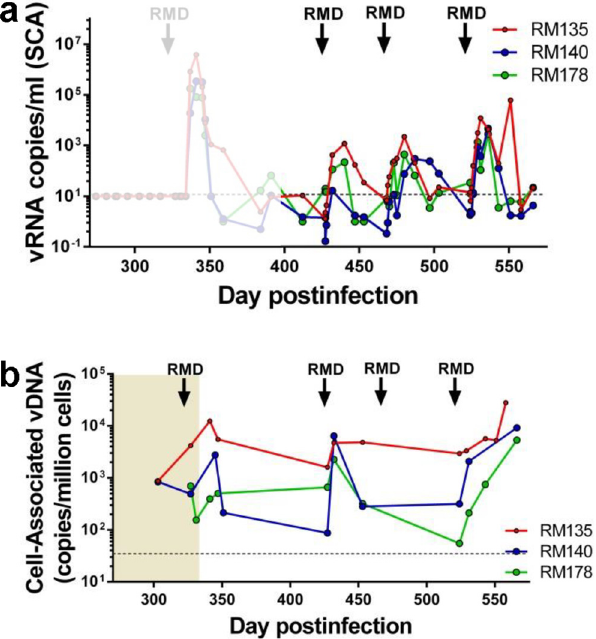
Fig 5. SIVsmmFTq reactivation after RMD administration in post-treatment controller RMs, as monitored by measuring the levels of PVLs and total CD4 + memory T cell-associated vDNA. (a) PVLs were measured using SCA, with a LOD of 1 copy/ml. Due to limitations in sample availability, the actual sensitivity of the SCA was of 5 – 10 copies (illustrated as a dashed line at 10 copies/ml). For comparison, the dynamics of PVLs at the cessation of ART are shown in shadow. (b) Total vDNA levels measured in memory CD4 + T cells from circulation. Times of the RMD administration are indicated with black